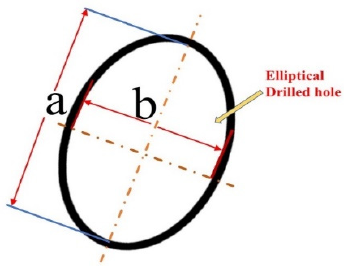
Figure 2. Elliptical approximation of a drilled hole at the entrance and the exit side.